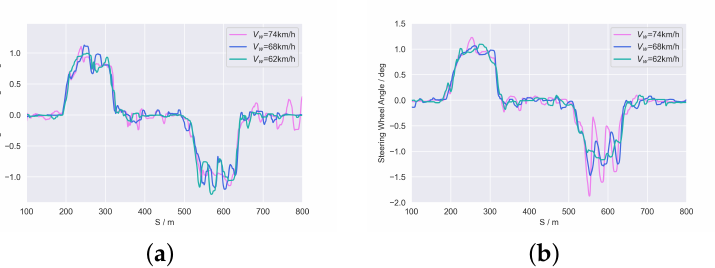
Figure 19. Steering FL wheel angle of the truck at driving speeds of ( a ) 30 km/h and ( b ) 40 km/h. By comparing the simulation results and experimental results in Figure 20, it is not difficult to find that the lateral acceleration results of the semi-trailer are similar under different running speeds and wind speeds. In actual driving, the vehicle is more sensitive to crosswind. Considering the influence of driver factors, the change of steering wheel angle will change the magnitude of lateral acceleration. On the one hand, the experimental results verify the influence trend of wind speed and vehicle speed changes on driving stability in the simulation. On the other hand, it also illuminates the changing trend of lateral acceleration. The results are in line with the above conclusions on the recommended speed and safe lateral acceleration.